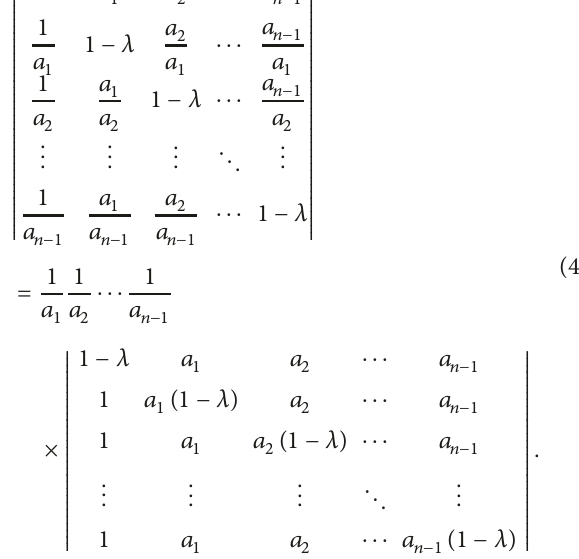
Figure 1: Records of AHP term in the